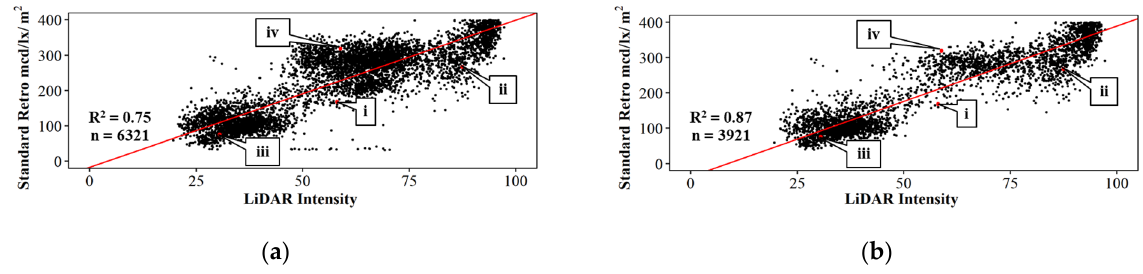
Figure 11. Right edge line linear correlation of LiDAR intensity and standard retroreflectivity: ( a ) US-52 and US-41 combined linear correlation of LiDAR intensity and standard retroreflectivity and ( b ) US-41 linear correlation of LiDAR intensity and standard retroreflectivity.